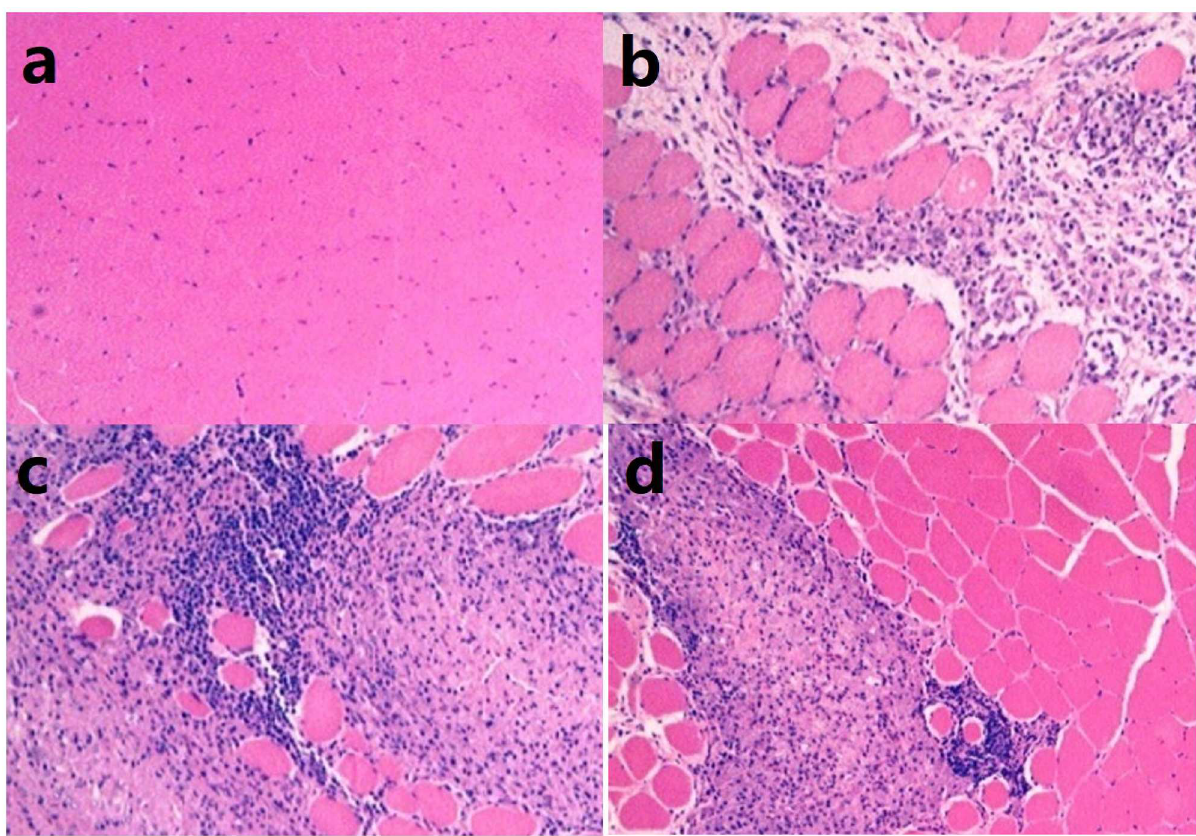
Fig 3. SBP could induce local irritation reaction. Representative photomicrographsof treated site are shown with originalmagnification: × 200 (HE staining). (a) NS group, 3 days after the last injection,normal tissue. (b) V+SBP (high dose) group, 3 days after the last injection, necrosis of myofiber (focal). (c) V+SBP (high dose) group, 3 days after the last injection, mesenchyme inflammatory cell infiltrationand macrophage aggregation(multi-focus). (d) V+SBP (high dose) group, at the end of the recovery period, mesenchyme inflammatory cell infiltrationand macrophage